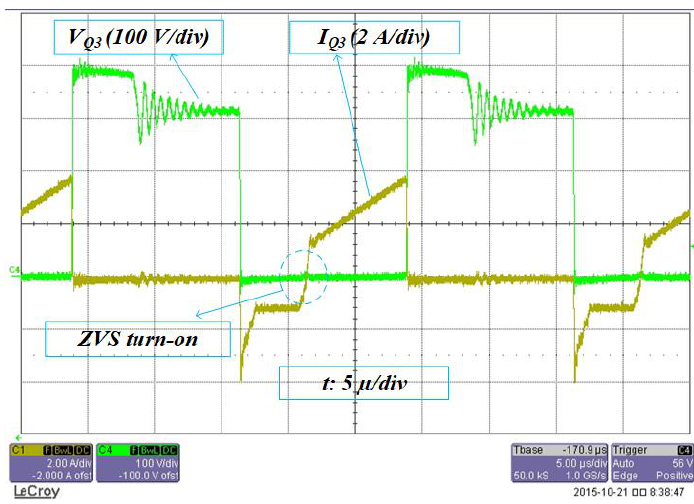
Figure 11. Voltage and current of switch Q 3 at 100% of load.